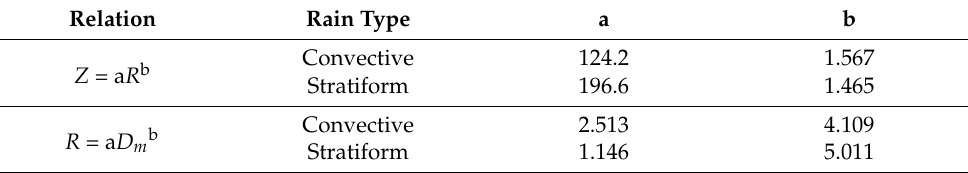
Figure 8. Scatter diagrams and their fitting curves of ( a ) R (mm h − 1 ) with Z (dBZ), and ( b ) D m (mm) with R (mm h − 1 ) from PARSIVEL disdrometer data for two rain types. The blue and red scatters represent convective and stratiform samples, respectively. The overlaid black line in panel ( a ) represents the experience relationship Z = 300 R 1.40 from Fulton et al. [34]. The black dashed (dash-doted) line in panel ( b ) represents the default relationship R = 1.370 D m 5.420 ( R = 0.401 D m 6.131 ) used for the retrieval of convective (stratiform) rain in GPM lev-2 ATBD [19]. Table 2. Exponential relationships of Z – R and R – D m derived from PARSIVEL disdrometer obser- vations for two rain types.